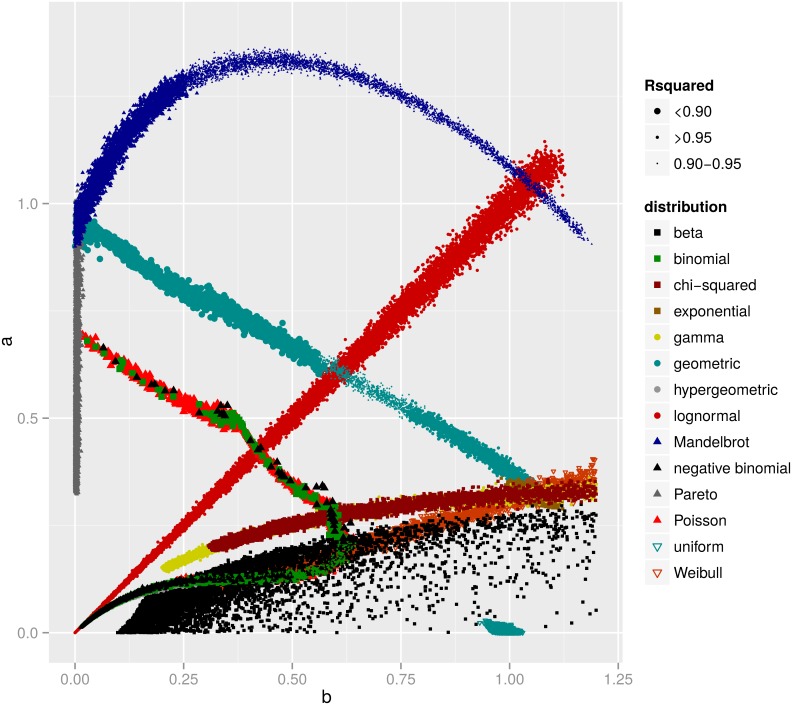
DGBD fits for various distributions.The estimated a and b parameter values in DGBD (Eq (1)) for data generated by well known distributions. Size of the dots indicate the coefficient of determination R squared. The dots around the a = b diagonal line are for data generated by the lognormal distribution.